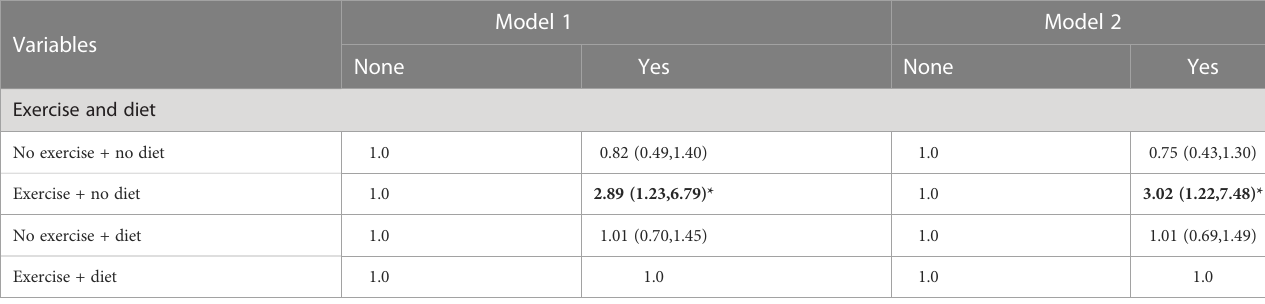
TABLE 17 The correlation between intervene and CVD